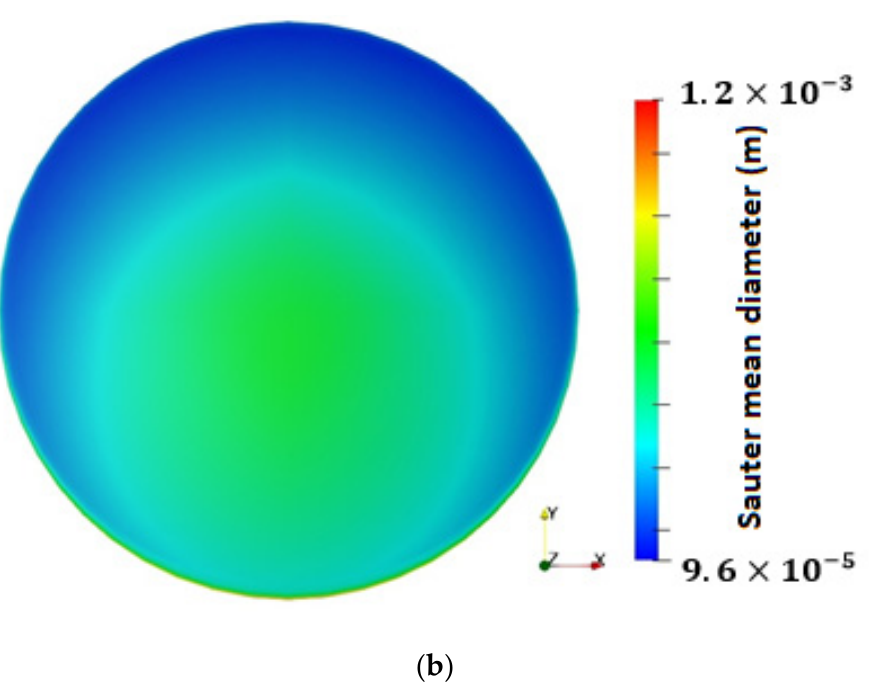
Figure 3. Contours of Sauter mean diameter (m) as obtained by CFD model ( a ) test 1 (V = 1.25 m/s, water cut = 0.05), ( b ) test 2 (V = 1.7 m/s, water cut = 0.05).